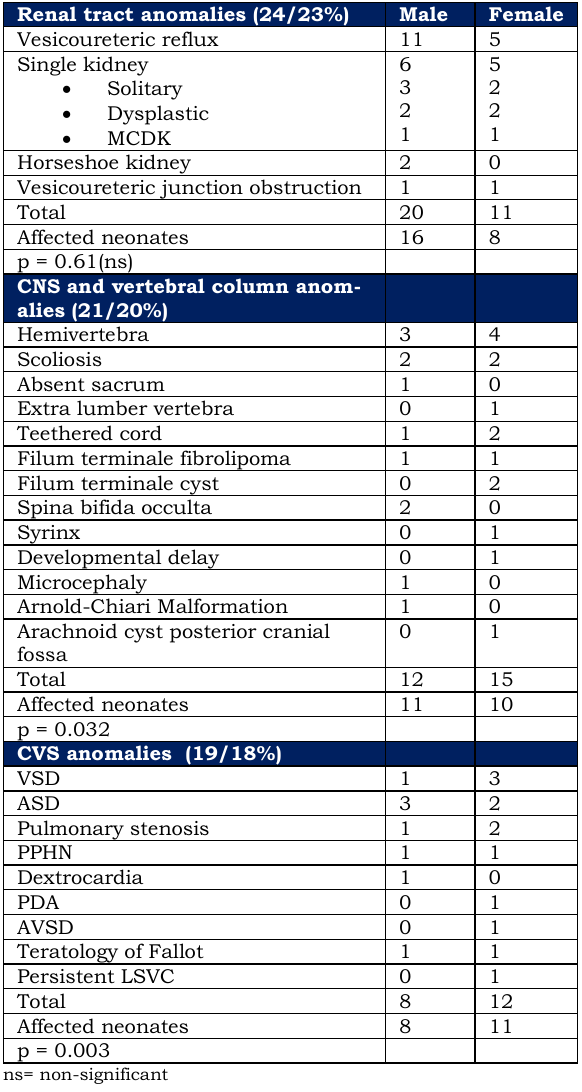
Table 3: Structural anomalies in the renal tract, the CNS and the cardiovascular system